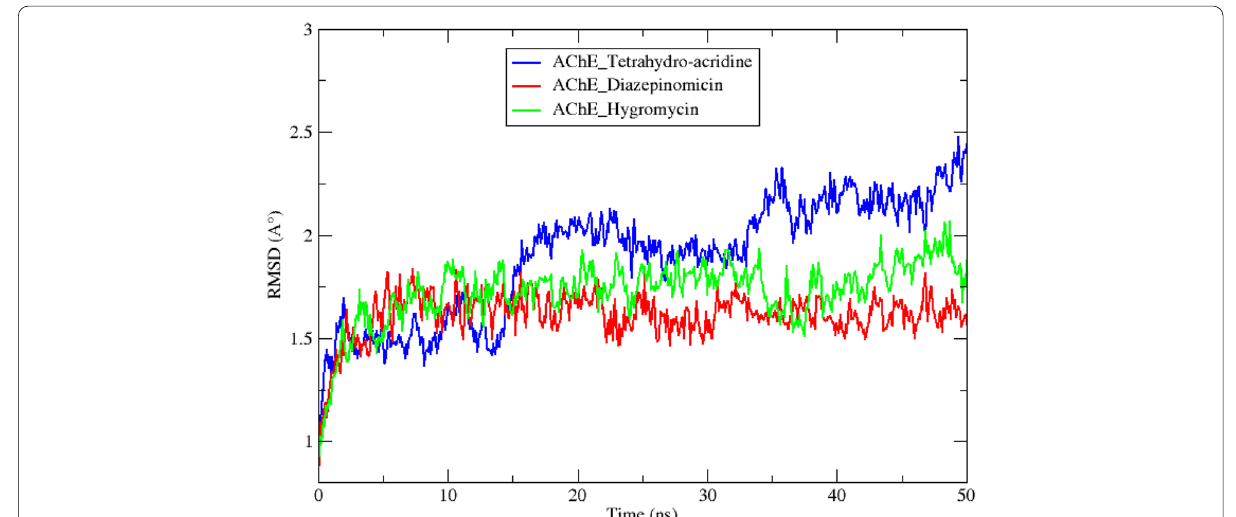
Fig. 4 RMSD of the reference and the two top complexes during 50-ns MD simulations